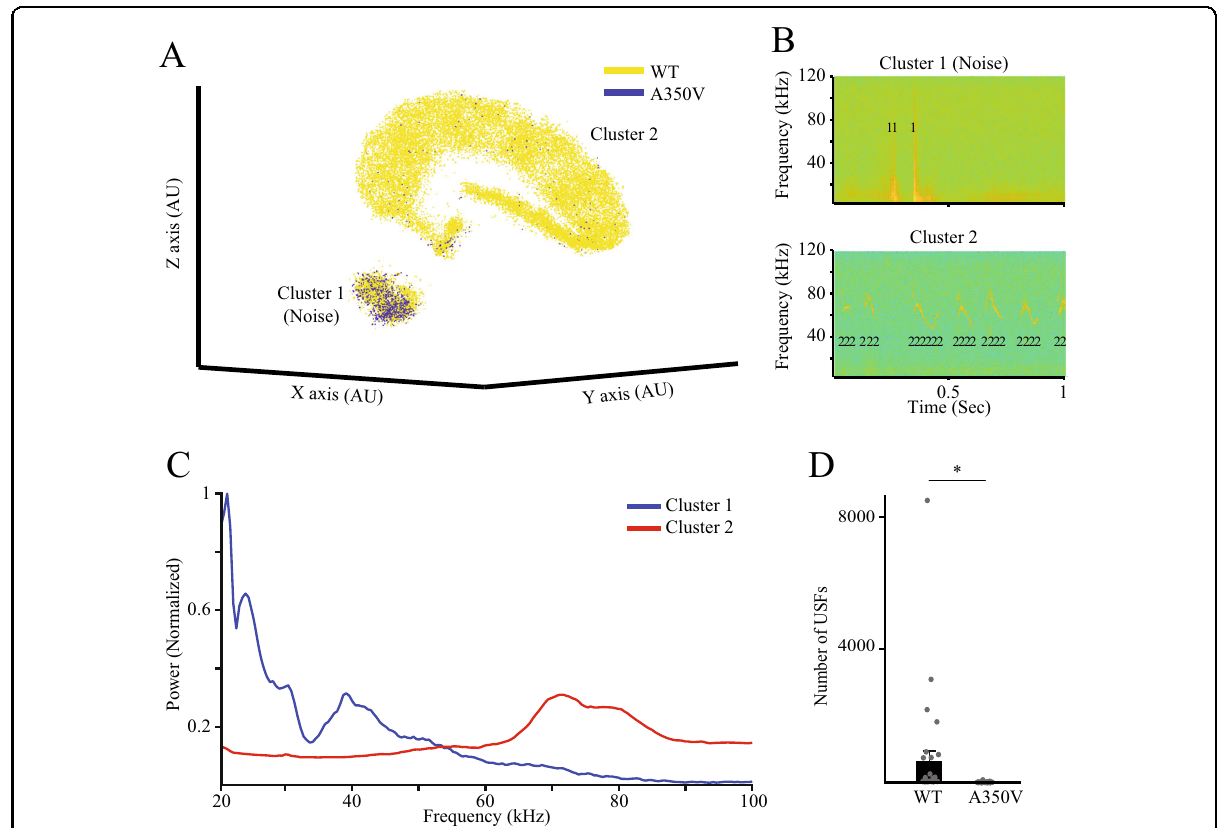
Fig. 3 A350V Iqsec2 male mice do not emit mating calls. A 3D t-SNE analysis of all ultrasonic fragments emitted by WT (yellow; n = 31) and A350V (blue; n = 36) adult male mice during an encounter with a female C57BL/6J mouse. Note that while cluster 1 (noise) seem to contain similar number of fragments from both genotypes, cluster 2 (vocalizations) contains almost only fragments from WT mice. B Examples of USFs, denoted by their cluster numbers, superimposed on the spectrograms of their respective audio signals. Note that USFs of cluster 1 (upper example) represent non- vocal (noise) signals while USFs of cluster 2 (lower example) represent genuine vocalizations. C Power Spectral Density (PSD) analysis of all USFs recorded from all animals, calculated separately for each cluster. Note that in contrast to the PSD pro fi le of cluster 1 which shows a wide range of frequencies, mainly at the lower range, the pro fi le of cluster 2 shows a clear peak at the range of 60 – 90 kHz. D Comparison of the number of USFs from cluster 2 between the two genotypes. Note that A350V mice emitted signi fi cantly lower number of USFs as compared to WT animals (Mann – Whitney U test. U = 399.000, * p < 0.05). All error bars represent